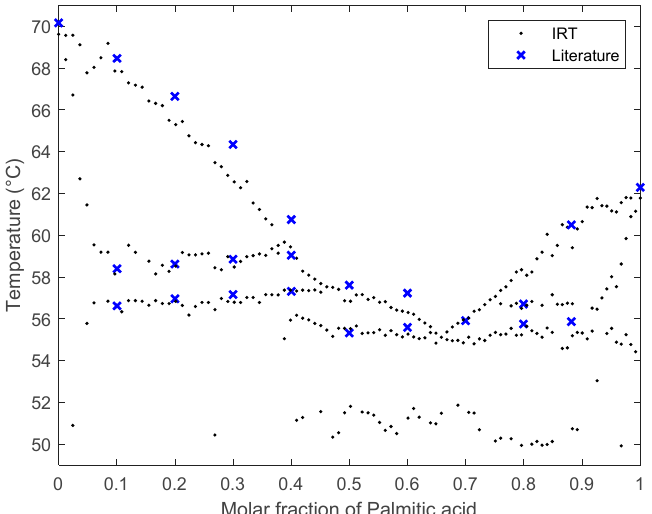
Figure 4. Phase diagrams comparison between the infrared thermometry method (IRT) experiment and literature data [15] for the palmitic acid (PA)–SA binary system.